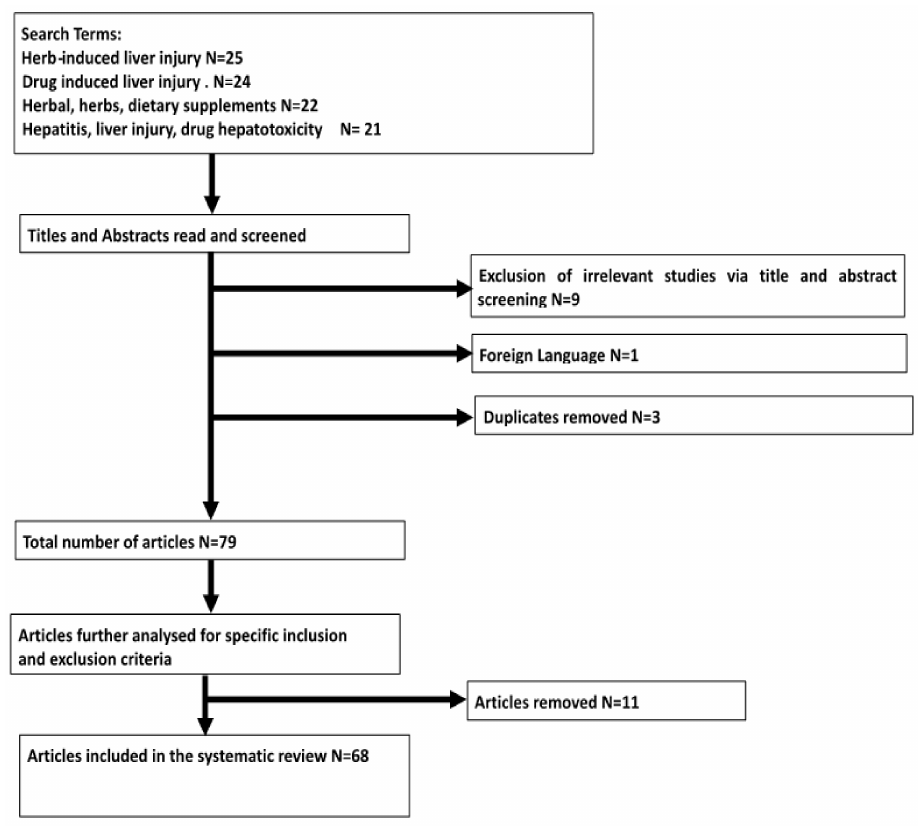
Figure 1. Study selection flow